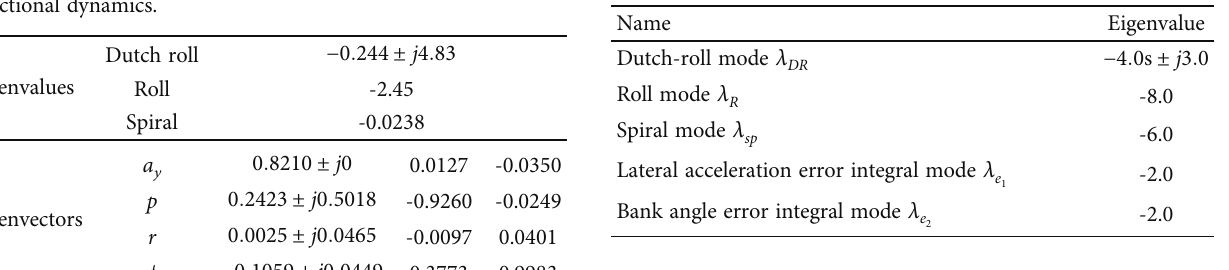
Table 6: Desired eigenvalues of the closed loop.